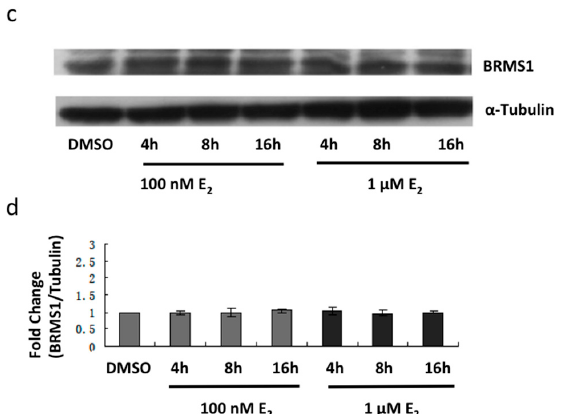
Figure 3. Analysis of BRMS1 protein expression induced by E 2 in SKBR3 cells. ( a ) SKBR3 cells were incubated with culture media containing 10 nM E 2 for 2, 4, 8, 16, 24, and 48 h. Control cells were incubated with culture media containing 10 nM DMSO; ( b ) Bar graph summarizes BRMS1 protein normalized to α -tubulin from the same lane from three independent experiments from ( a ); ( c ) SKBR3 cells were incubated with culture media containing 100 nM E 2 or 1 µM E 2 for 4, 8, and 16 h. Control cells were incubated with culture media containing 100 nM DMSO for 2 h; ( d ) Bar graph summarizes BRMS1 protein normalized to α -tubulin from the same lane from three independent experiments from ( c ). At each time interval, cells were harvested and 20 µg of the total protein was loaded for each sample to determine BRMS1 expression by Western blot. For all samples, α -tubulin was used as the loading control. Each band present was quantified using Image J and graphed as previously described. The bar graphs and error bars represent the average of three independent experiments ± S.D. No statistical significance was observed.